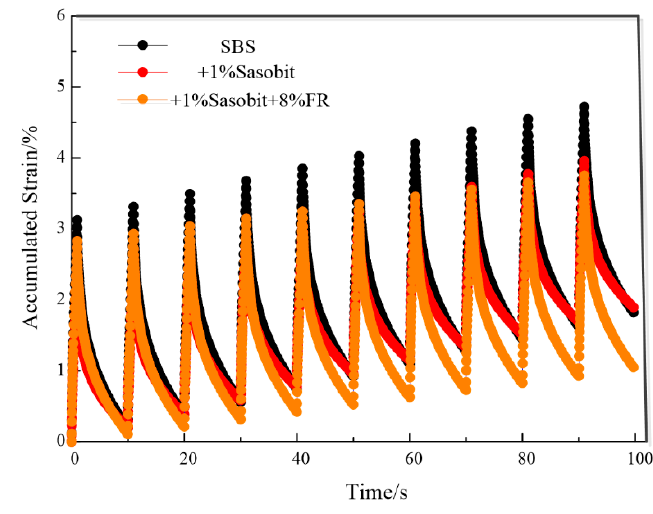
Figure 8. Strain response of asphalt binder at 50 °C.